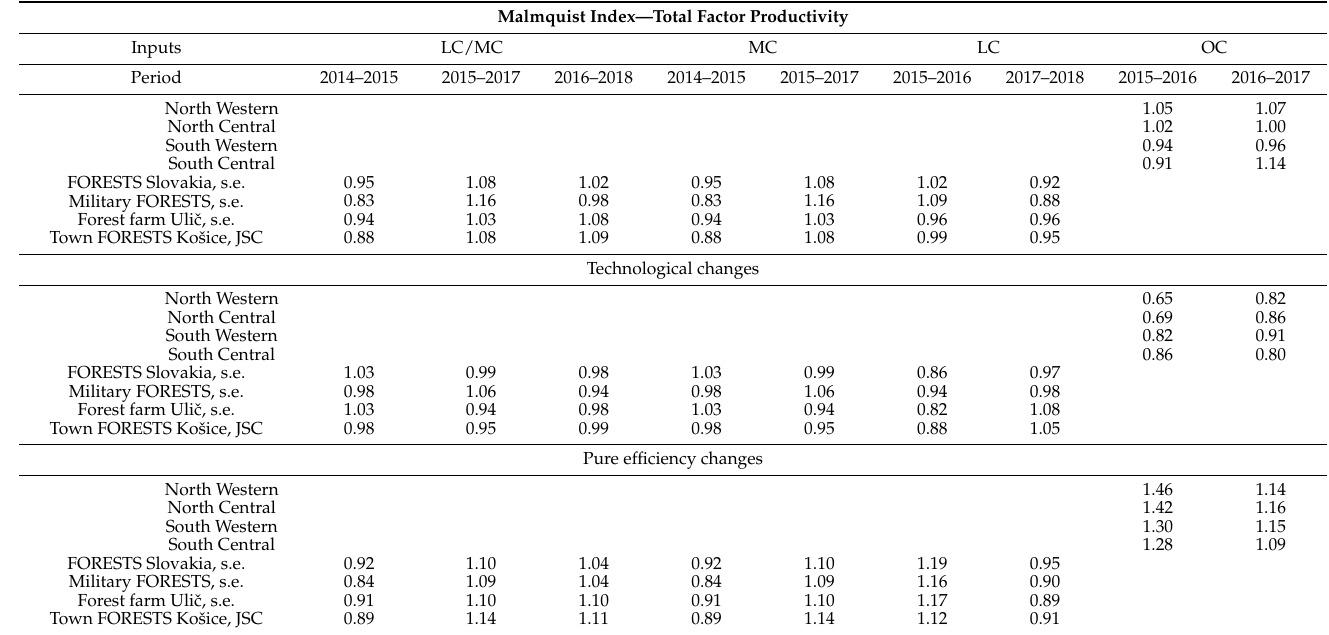
Table 5. Malmquist Productivity Index of the investigated enterprises only for the statistically significant periods of changes.